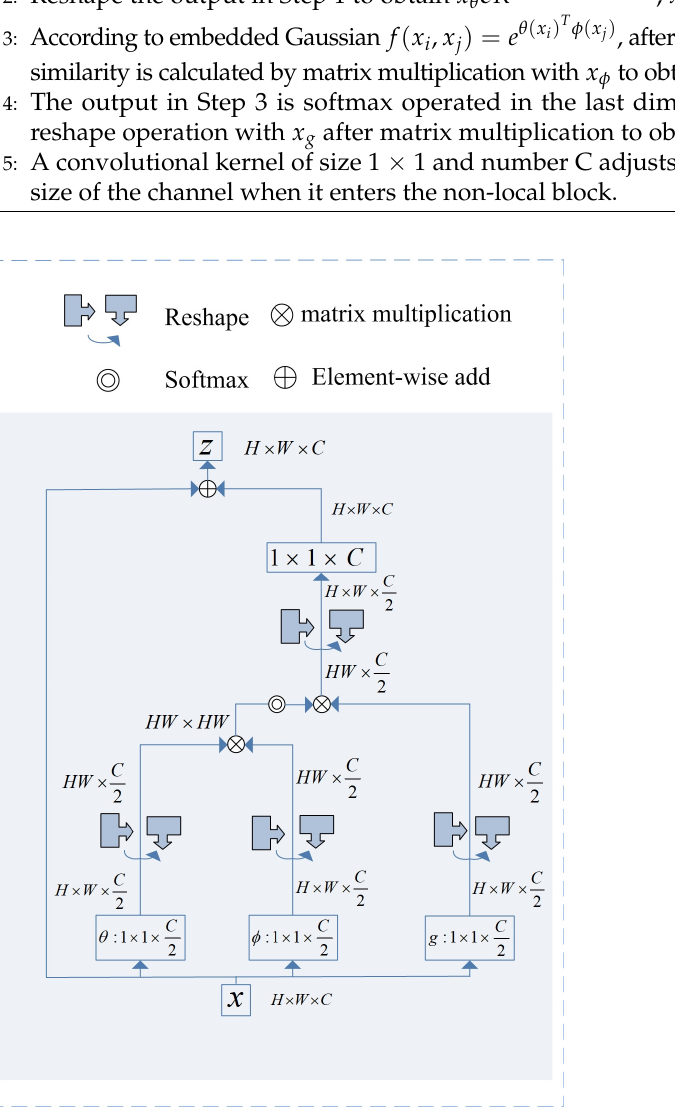
Figure 6. Non-local